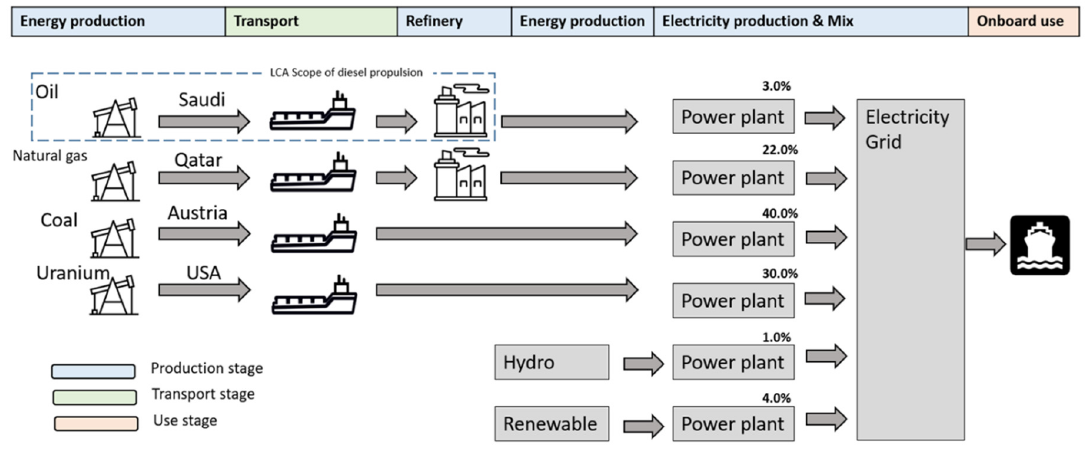
Figure 6. Lifecycle modelling for electricity grid for South Korea.